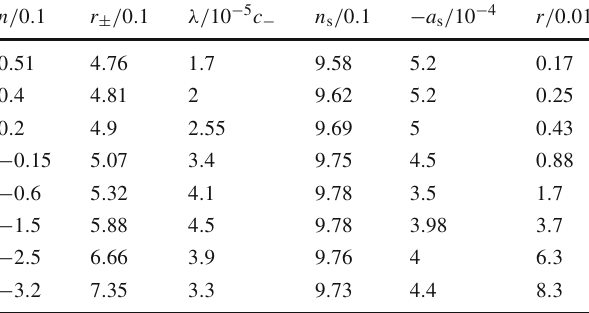
for K = K 1 (dashed lines) or K = K 2 and K 3 (solid lines). The values of the curves which are preferred by the observational data at 68% c.l. [95% c.l.] are included